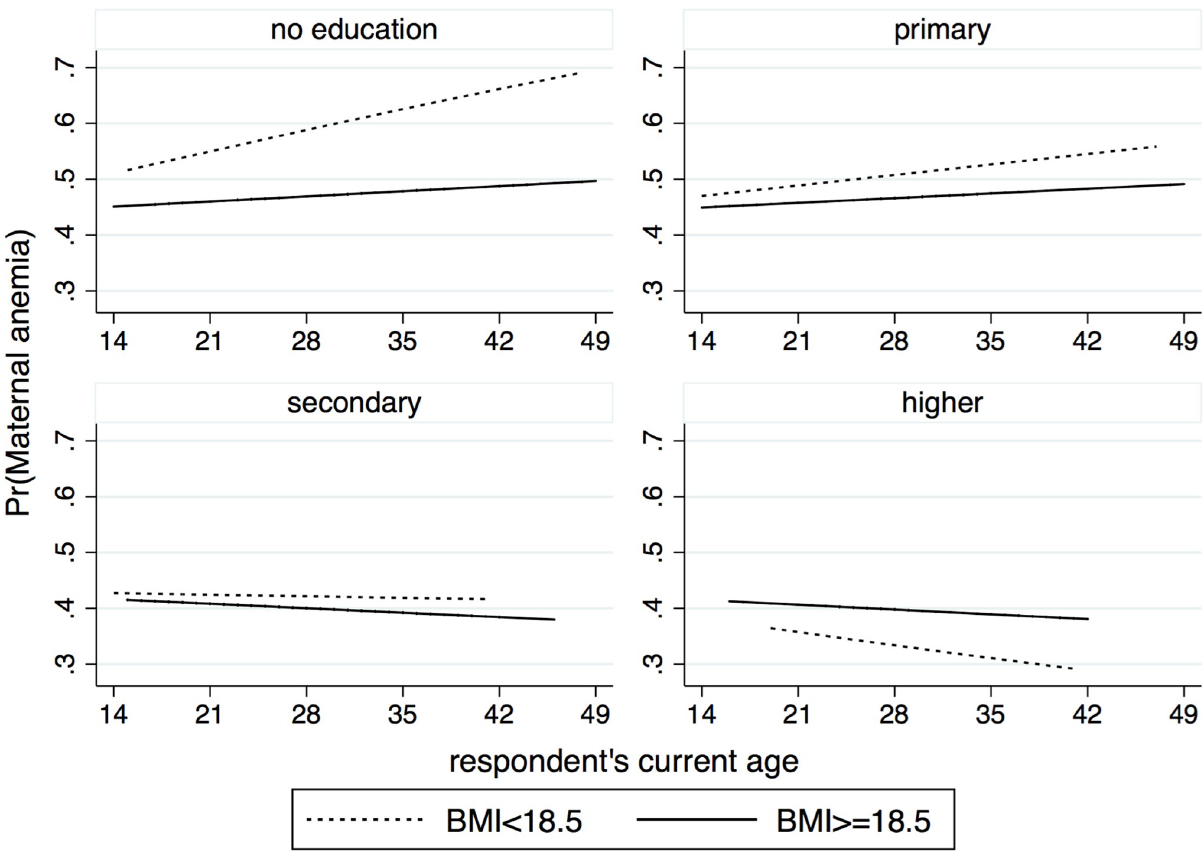
Fig 3. Interaction plot describing the association of BMI interact with education and age on the risk of maternal anemia.